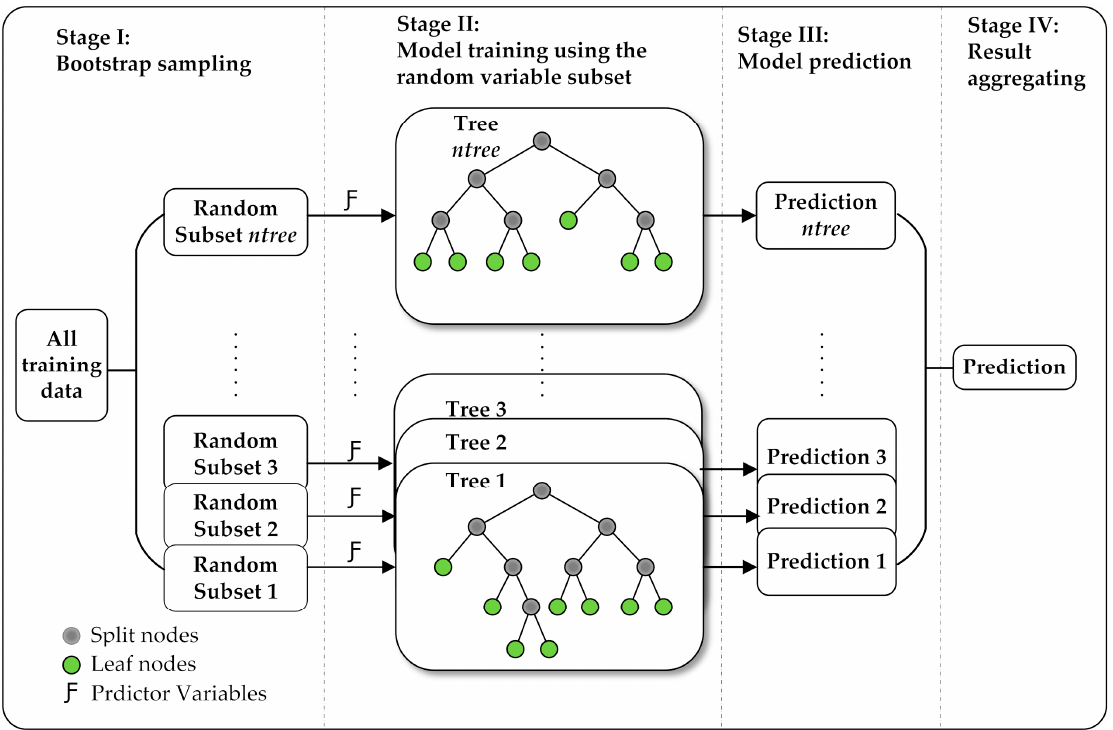
Figure 2. Schematic of the random forest regression algorithm based on the Bagging (Bootstrap Aggregating) method.